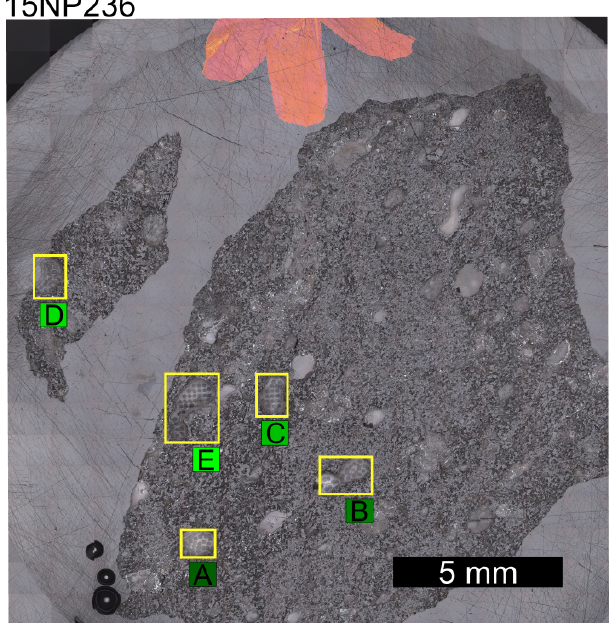
Figure A4. Reflected light image of sample 15NP236 with marked ablation areas. Letter, attached to the yellow boxes, appended to the sample name, labels the ablation areas. Colors of label boxes are consistent with colors of in-text